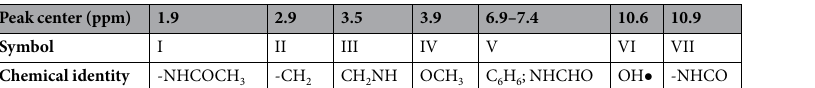
NHCHO). Free melatonin is degraded into other compounds that appear at 3.2, 3.6 and 3.78 ppm and predom- inantly at 10.6 (OH • ) and 10.9 (NHCO) ppm. Melatonin in PolyRad nanoparticles did not show any significant differences between the non-radiated control and gamma irradiated PolyRad samples. The percentage of active melatonin remaining was calculated using the integral ratio of peaks of groups I through V (Table 2) based on the non-radiated melatonin control (Fig. 7b). The structural integrity of melatonin alone was completely degraded to 25.7, 10.8 and 5.5% at 1, 5 and 10 Gy, respectively compared to non-radiated free melatonin. The nanoparticle plays a critical role in the protection of melatonin by > 98% most likely by scavenging of free radicals generated from gamma radiation 62 .